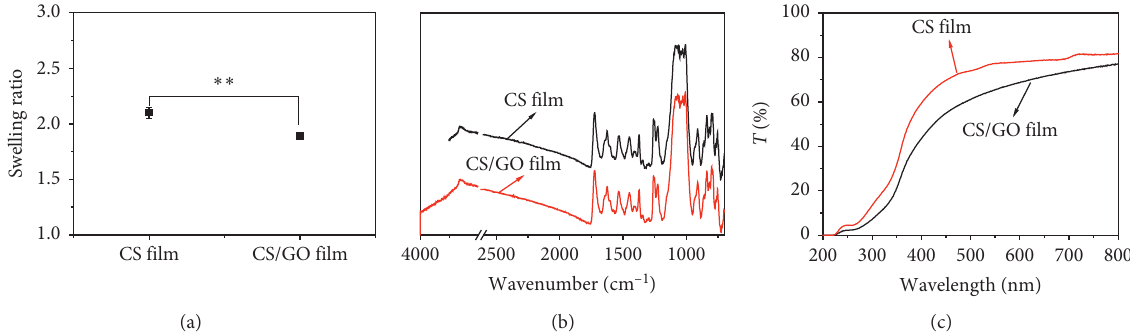
Figure 2: (a) Swelling ratio of CS film and CS/GO film ∗ p < 0 . 05 and ∗∗ p < 0 . 01; (b) FTIR spectra of CS film and CS/GO film; (c) transparency of CS film and CS/GO film.